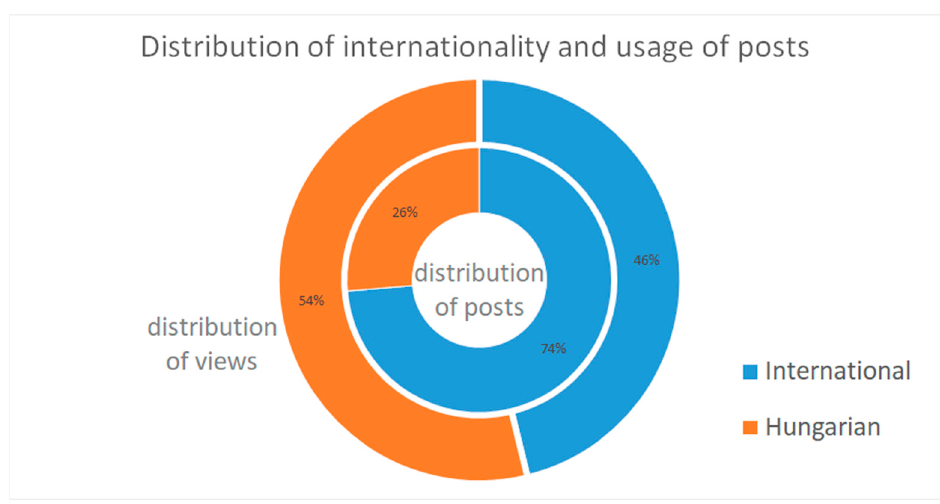
Figure 3. Distribution of internationality and usage of posts.